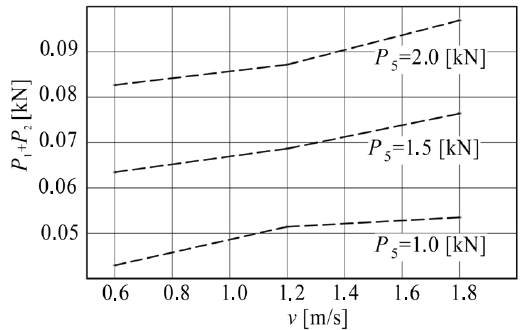
Figure 14. The dependence of the change in the tractive resistance P 1 + P 2 of the slotting disk with the balancing wheel depends on the working speed and the value of the vertical reaction P 5